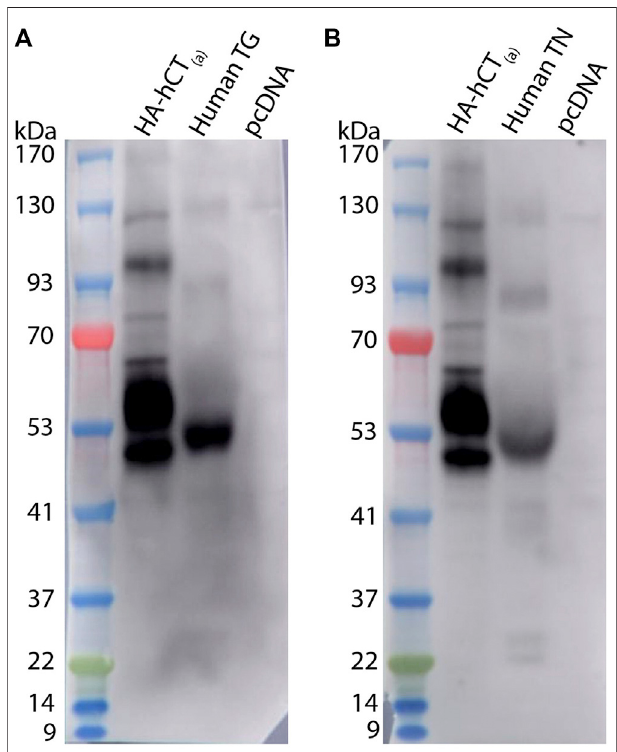
FIGURE9| CTR-likeimmunoreactivity inhumanTGandTNlysateusing immunoblotting. Immunoblots using lysate preparations from human TG and TN (20 µg)or HEK293Scells (10 µg)transfectedwith HA-tagged human CT (a) or vector alone (pcDNA). Blots were probed with mAb31-01 (2 µg/ml), comparing immunoreactivity in (A) TG (case 1322) and (B) TN (case 1543). MWmarkersareshownontheleftofeachblot,withapparentMWinkDa.This image is from one western blot for two human cases. Images were adjusted uniformly for brightness and contrast for presentation